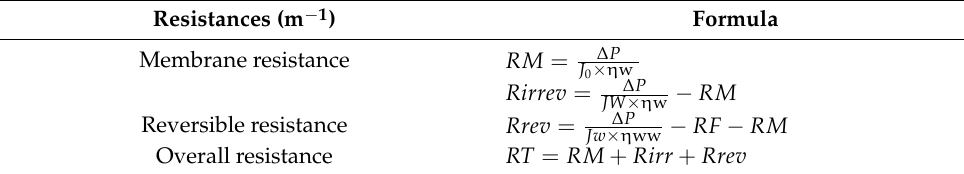
Table 5. Formulas for filtration